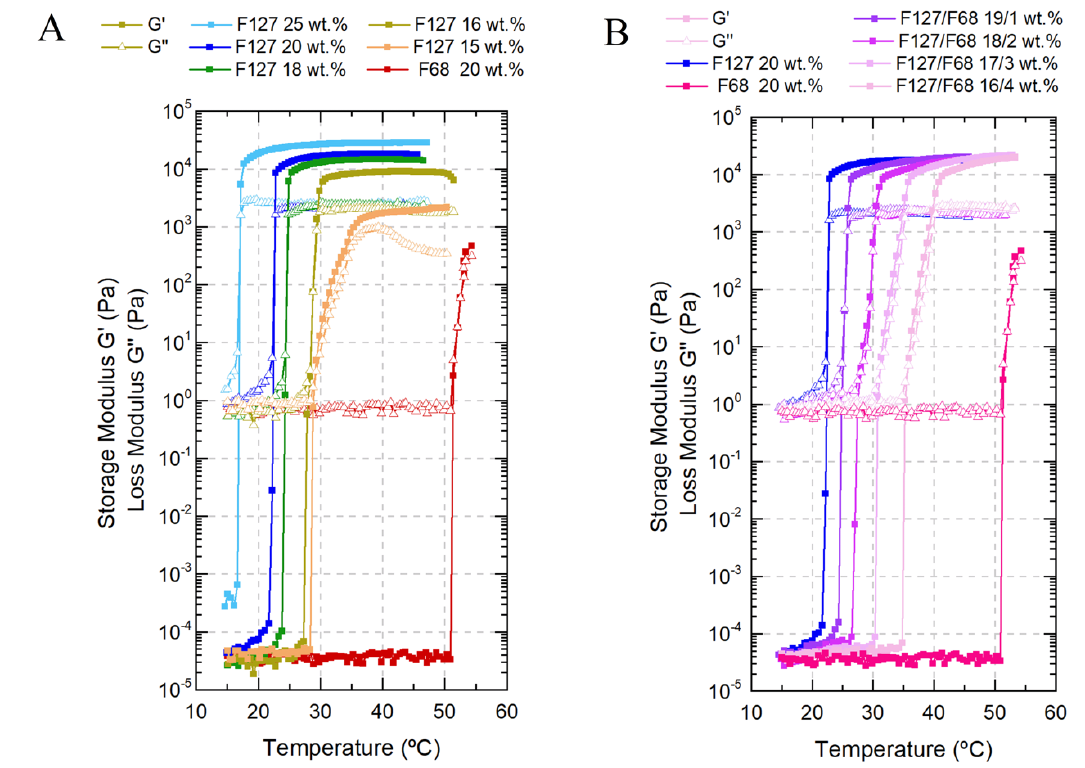
Figure 1. Viscoelastic behavior of all Pluronic formulations as a function of temperature: ( A ) single F127 formulation with concentrations ranging from 15 wt.% to 25 wt.%, and F68 formulation with a concentration of 20 wt.%; ( B ) binary F127/F68 with weight ratios from 20/0 (F127 20 wt.%) to 16/4 (F127/F68 16/4wt.%).